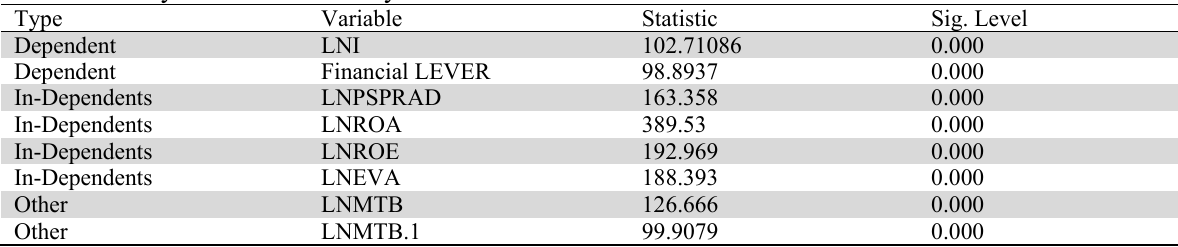
The Summary of Results Stability Test